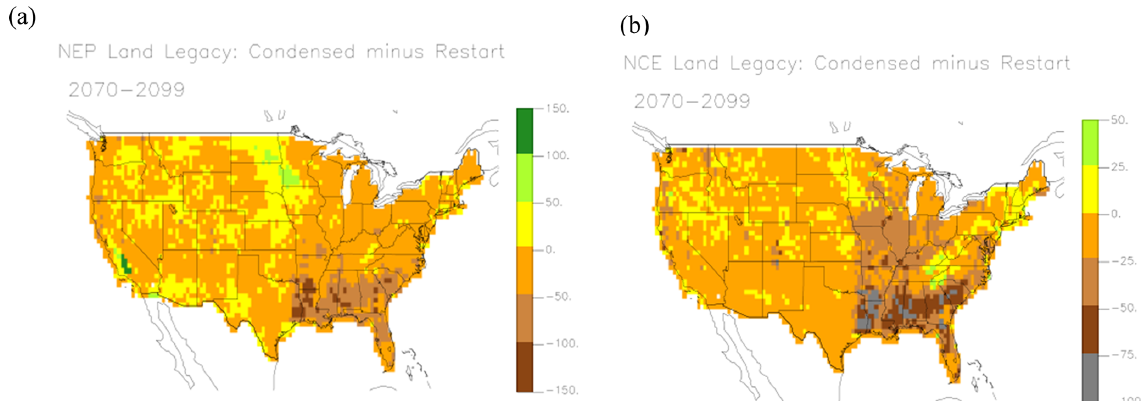
Figure 4. Mapped differences in NEP and NCE, illustrating effect of land legacy as difference between the CONDENSED and RESTART